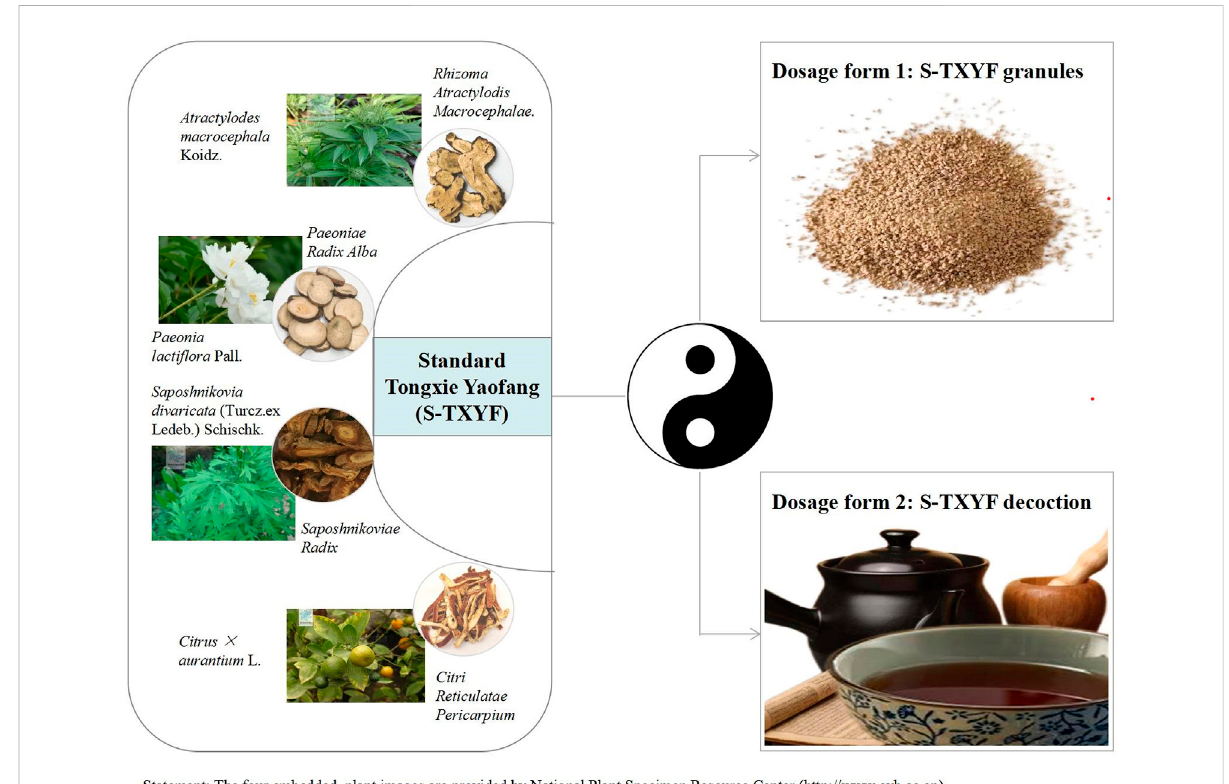
FIGURE 1 The composition and clinical dosage forms of standard Tongxie